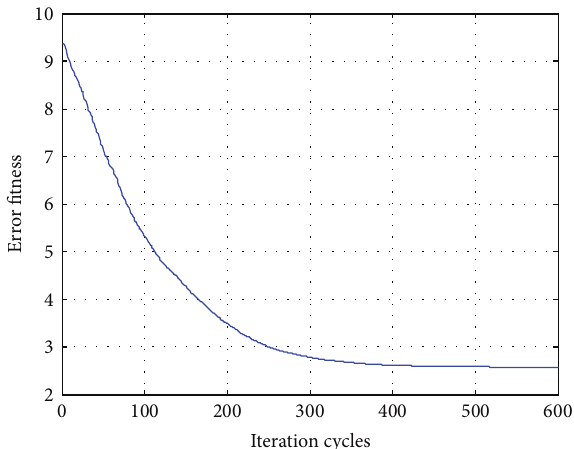
Figure 18: Convergence profile for PSO in case of FIR HP filter of order 20.